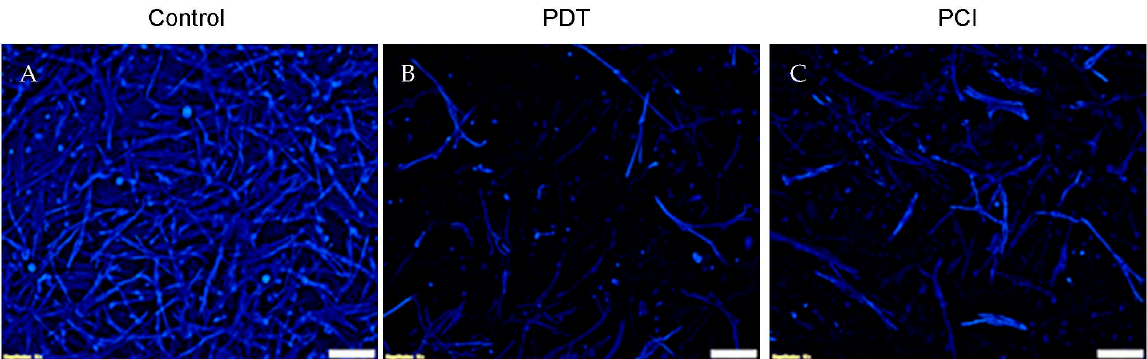
Figure 5. ( A ) Overall images of the cancer cell population stained with anti-cytokeratin 7 (Alexa Fluor 488) λ Ex/Em: 490/525 (green) within the central cancer mass of the simple tumouroids for each treatment condition; Control simple tumouroid construct ( I ), PDT in simple tumouroid construct using TPPS2a (0.5 µ g/mL) only ( II ), Saporin only ( III ), and PCI ( IV ); ( B ) Histograms showing distance ( µ M) invaded within the tumouroid stroma by cancer cells post PDT and PCI treatments described in Figures 4A and 4B. Distance ( µ M) invaded within stroma invaded by cancer cells after PDT treatment using TPPS 2a (1 µ g/mL) ( I ). Distance µ (M) invaded within stroma invaded by cancer cells after PCI treatment using TPPS 2a (0.5 µ g/mL) and Saporin (20 nM) ( II ). The invasion distances presented are averages from 24 measurements taken from different areas all around the original cancer mass of each tumouroid. Each measurement was taken from the border of the original cancer mass to the furthest point of invasion in the stroma which lay in the same direction as the starting point of the measurement. *** p < 0.001 shows the significant difference in the distance invaded in the stroma by cancer cells post PDT and PCI. The scale bar presented in the images is 200 µ m.